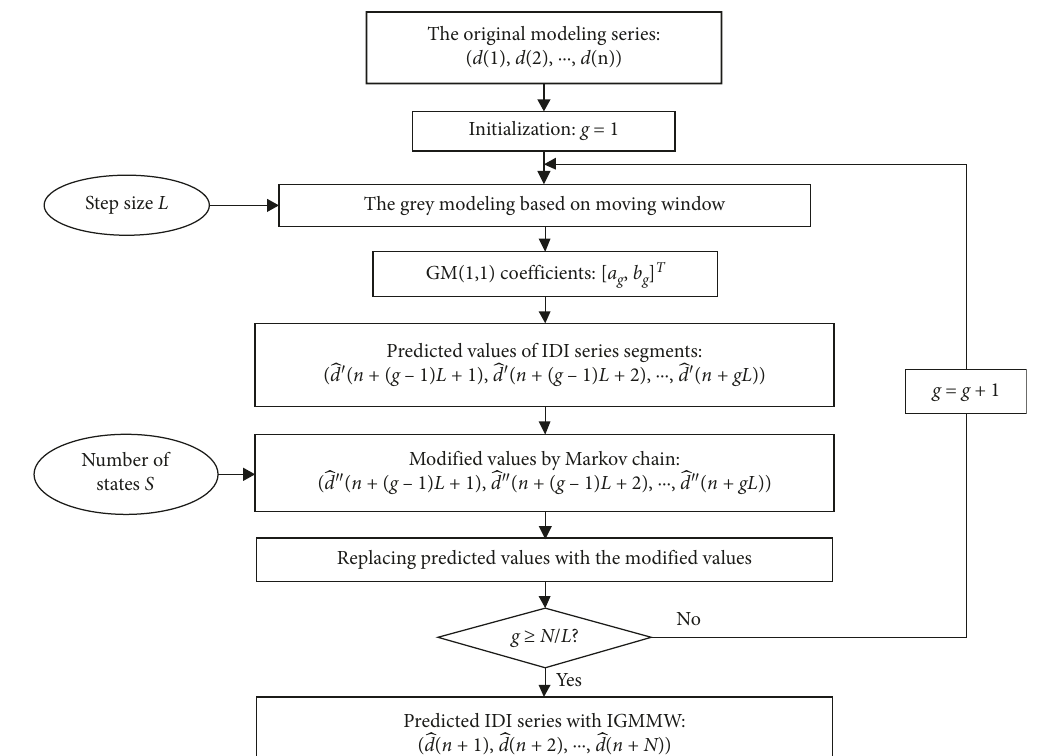
Figure 2: Flowchart of the trend forecasting based on the